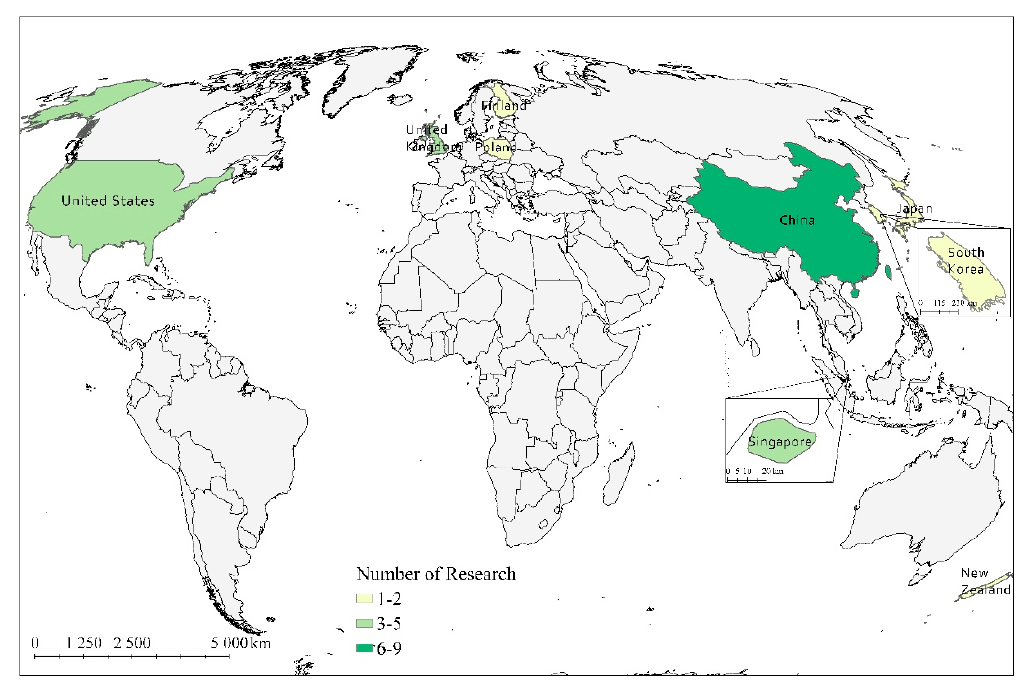
Figure 3. Spatial representation of countries in which social media platforms were used in the 22 studies. Base map credits National Geographic Society.